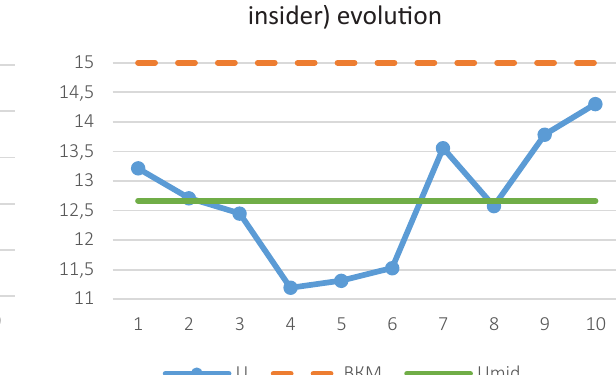
Figure 7. The Shewhart chart for the H8 (high credit risk) evolution